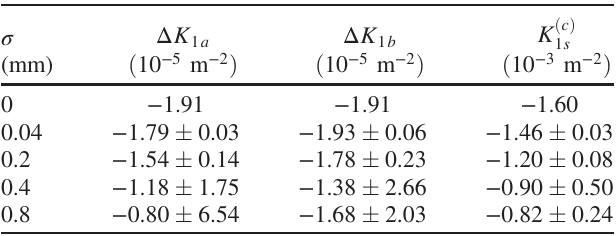
TABLE IX. Corrector strengths estimated from the fitting procedure explained in Appendix C. The strengths reported in each row correspond to the average of strengths estimated from ten different TBT data sets with Gaussian noise. The uncertainties are estimated as 3 times the standard deviation.